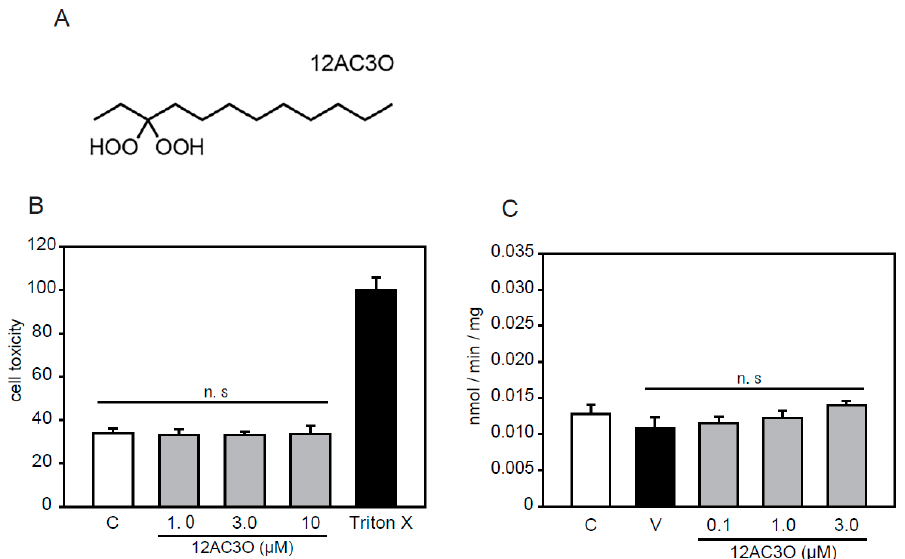
Figure 1. gem -Dihydroperoxide (DHP) selection and cytotoxicity evaluation. ( A ) Chemical structures of 12AC3O. ( B ) p53LMAco1 cells were cultured with Fetal Bovine Serum (FBS) -free medium in the presence or absence of DHPs (1.0, 3.0, and 10 µ M for 24 h). The cytotoxicity of 12AC3O was measured using the lactate dehydrogenase (LDH) assay. Triton-X was used as a maximum LDH activity control. Results are presented as the mean ± standard error of the mean (S.E.M) of eight independent experiments. ( C ) The phosphate (Pi) uptake assay was performed in p53LMAco1 cells treated with Pi and 12AC3O for 24 h. C: Control (1.0 mM Pi), V: Vehicle (3.0 mM Pi). n.s: not significant.